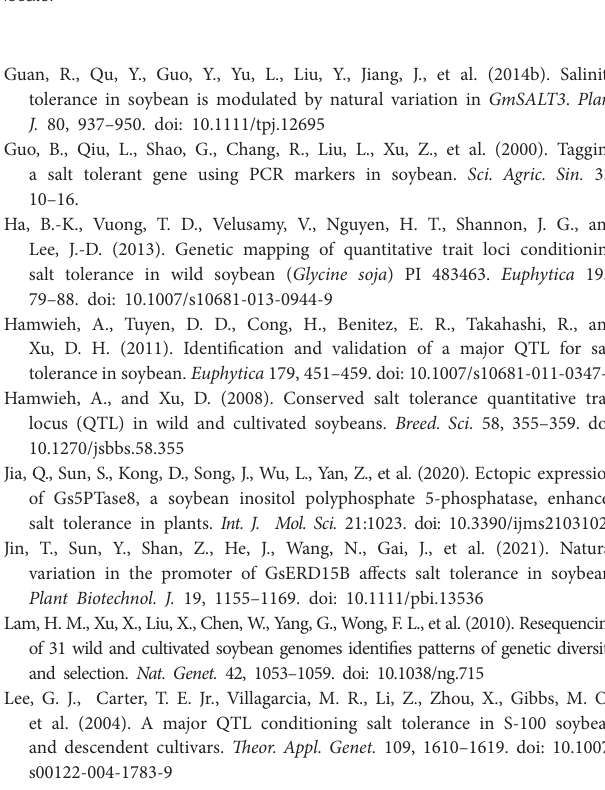
Supplementary Figure 1 | Distribution of 543 simple sequence repeat (SSR) markers used for polymorphic markers selection in bulked segregant analysis (BSA) analysis of F 2 population derived from a cross of Peking and NY36-87. Supplementary Figure 2 | Physical position of the potential genomic structure variation (between Glyma.18g026700 and Glyma.18g026900 ) in different assemblies of soybean accessions on Chr. 18. Box indicates where the variations